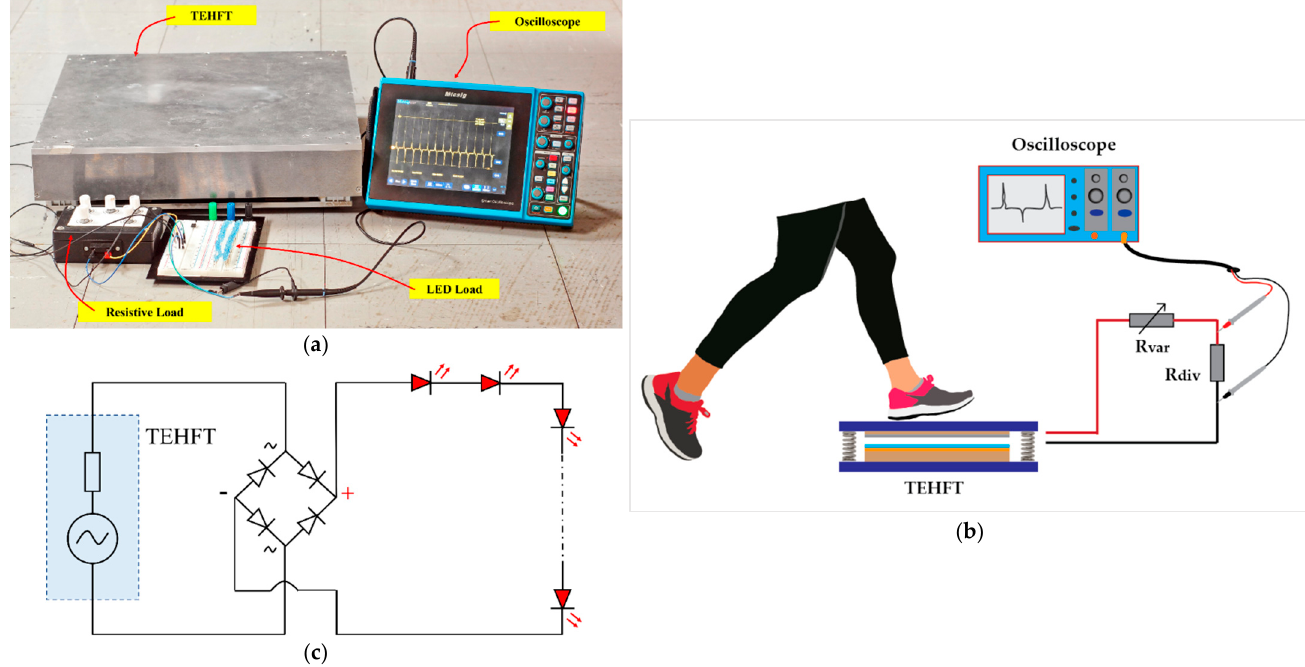
Figure 8. Experiment setup for the TEHFT: ( a ) Laboratory measurement setup; ( b ) the schematic of the experimental setup; and ( c ) schematic of the series LED load connected to the